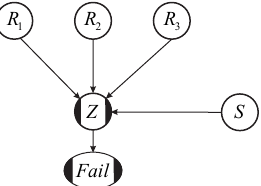
Figure 5. Example of a Bayesian Network (BN) for cross sectional levee failure probability with three resistance variables R 1 , R 2 , and R 3 , and a load variable S